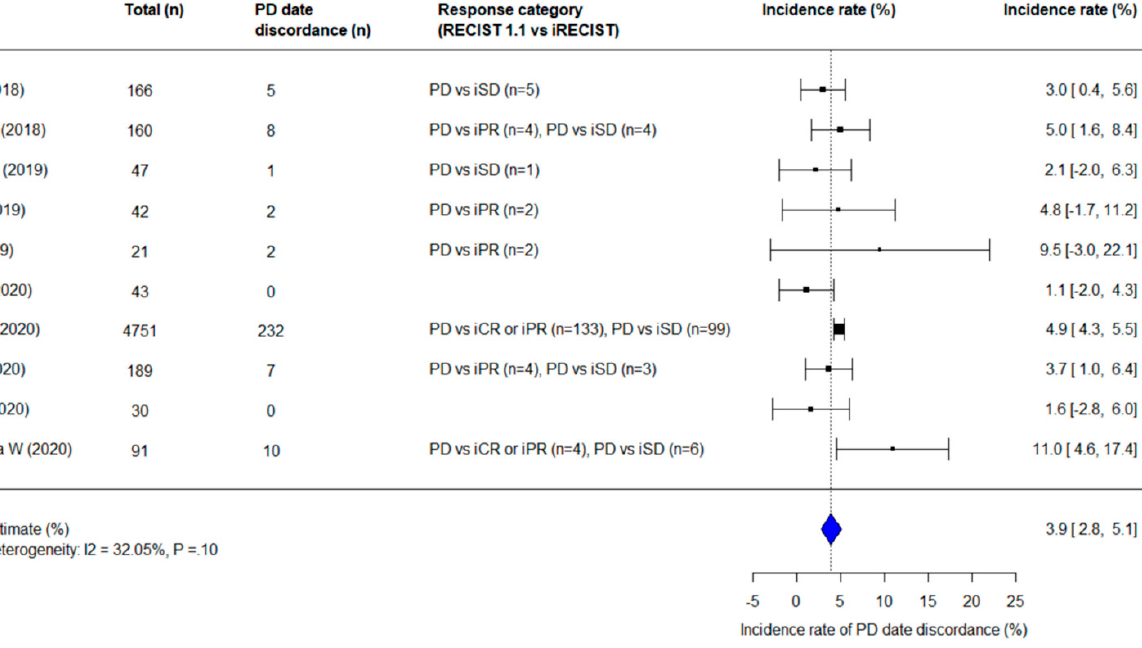
Figure 3. A forest plot showing the pooled incidence rate of PD date discordance between RECIST 1.1 and iRECIST. The pooled incidence rate of PD date discordance between RECIST 1.1 and iRECIST was 3.9%; 95% CI, 2.8–5.1%). “i” indicates immune responses assigned using iRECIST. Abbreviation: CR, complete response; PD, progressive disease; PR, partial response; SD, stable disease.